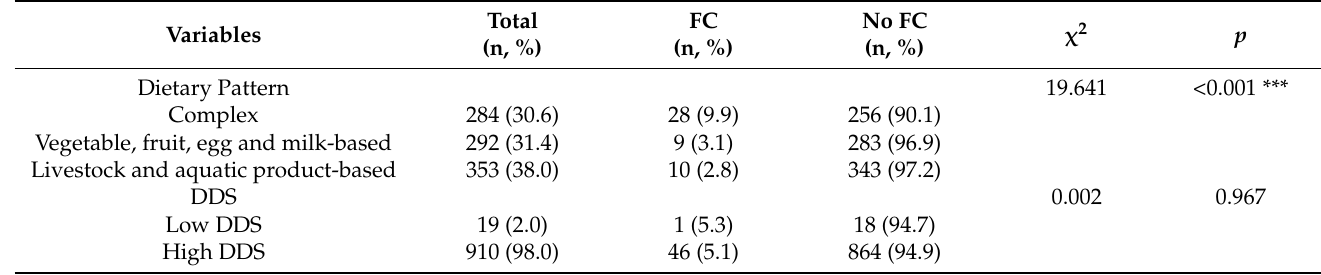
Table 4. Association between dietary patterns, DDS, and FC among university